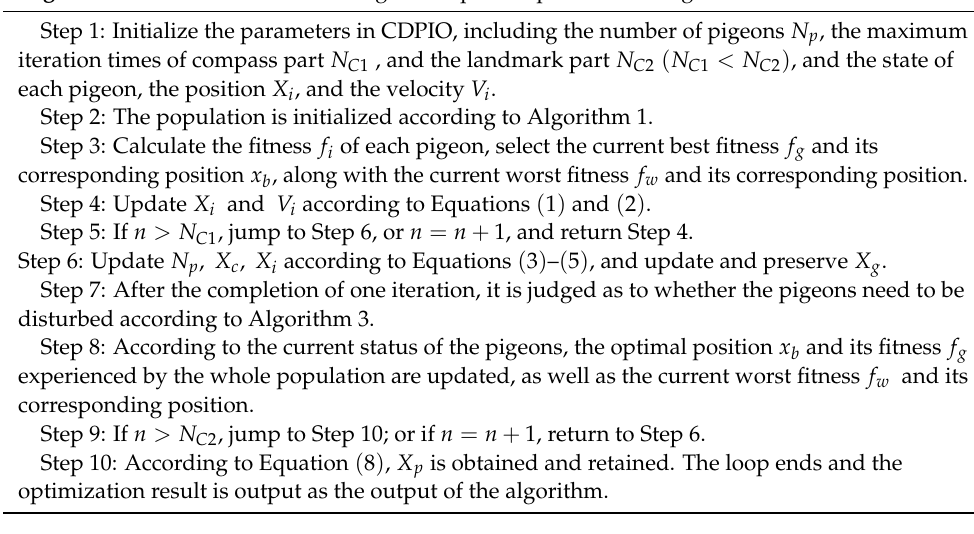
Algorithm 3 Chaotic Disturbance Pigeon-inspired Optimization